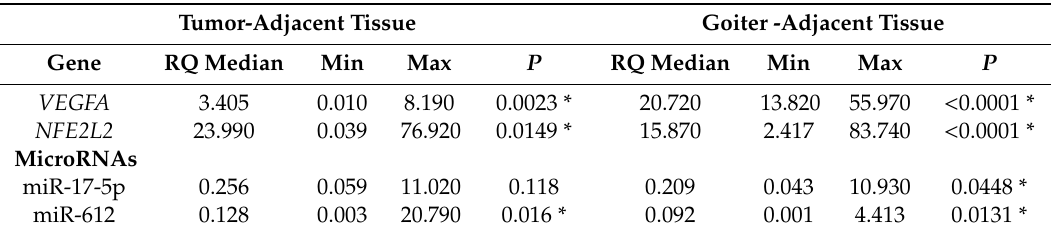
Table 3. Gene and miR expression in tumor- and goiter-adjacent tissues in relation to normal thyroid tissue. Tumor-Adjacent